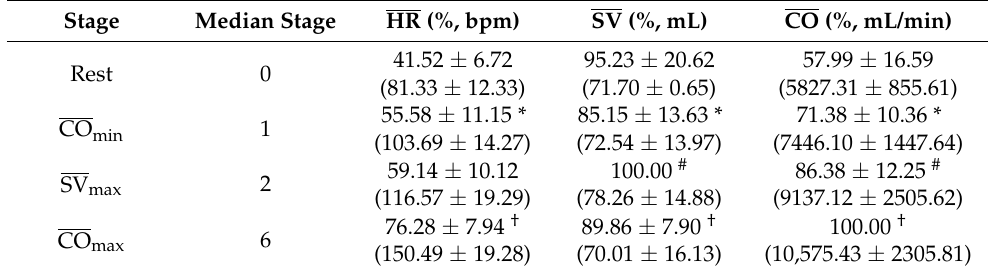
Table 2. The result of heart rate (HR), stroke volume (SV), and cardiac output (CO) at different stages during incremental exercise and